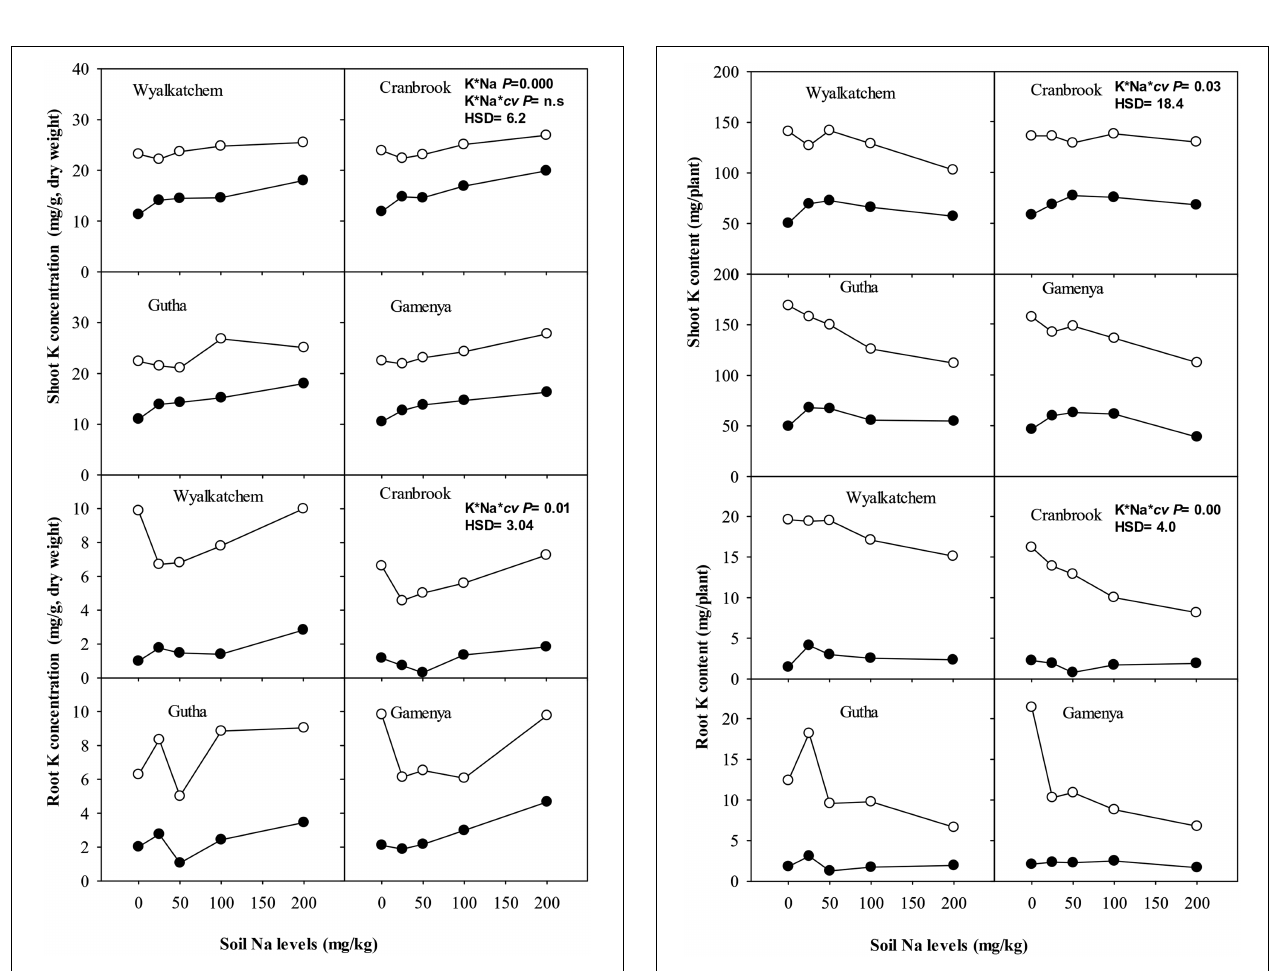
FIGURE 4 | Potassium (K) concentration (mg/g, dry weight) in shoot (upper sub-figures) and root (lower sub-figures; n = 3) of four wheat cultivars, treated with 40 mg K/kg (closed circle) and 100 mg K/kg (open circle), and five soil Na levels (0, 25, 50, 100, and 200 mg Na/kg) for 8 weeks. See Table 2 for analysis of variance results.